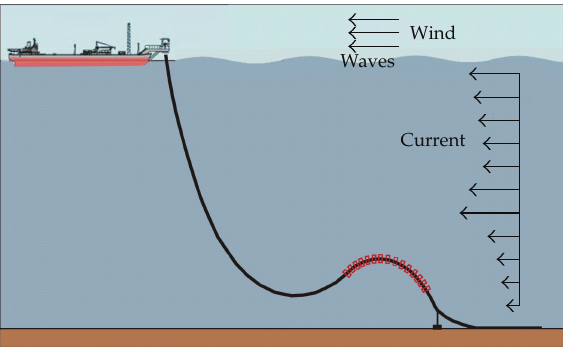
Figure 2: Environmental loads in flexible risers.